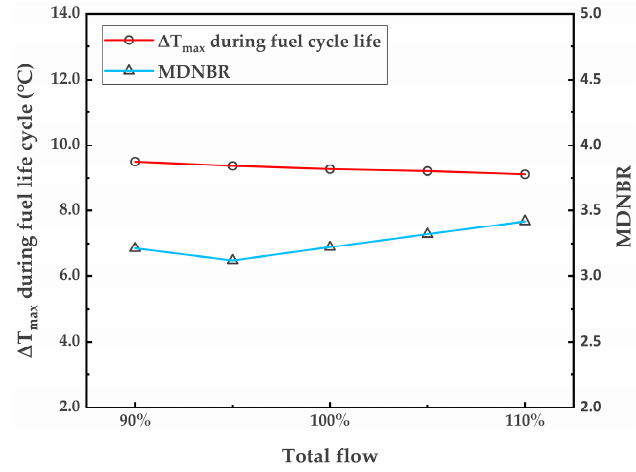
Figure 8. Optimization results under different total flows.